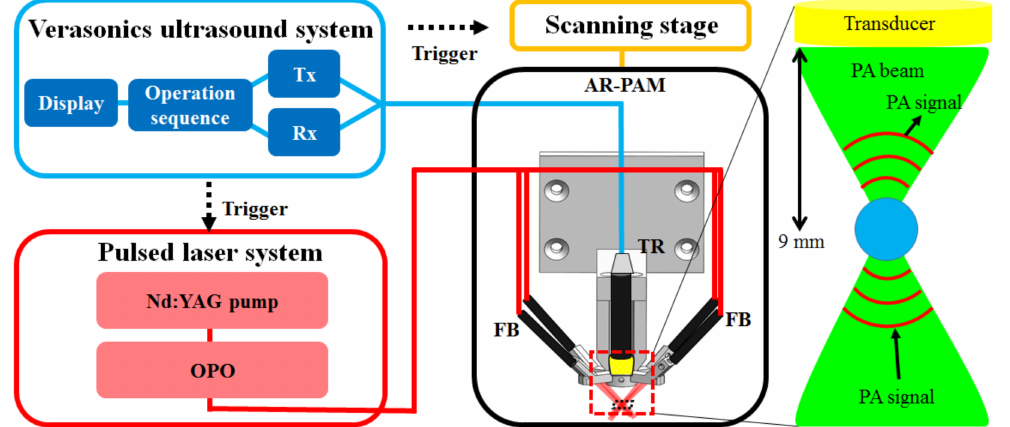
Figure 2. Operation sequence of the AR-PAM imaging system. A Verasonics US system sends trigger signals to an OPO laser to output a 20 Hz pulsed laser to the AR-PAM probe through a removable fiber bundle. PA signals generated by laser excitation are detected using a 50 MHz US transducer and are subsequently processed by a PC for data analysis and image processing. TR: US transducer;